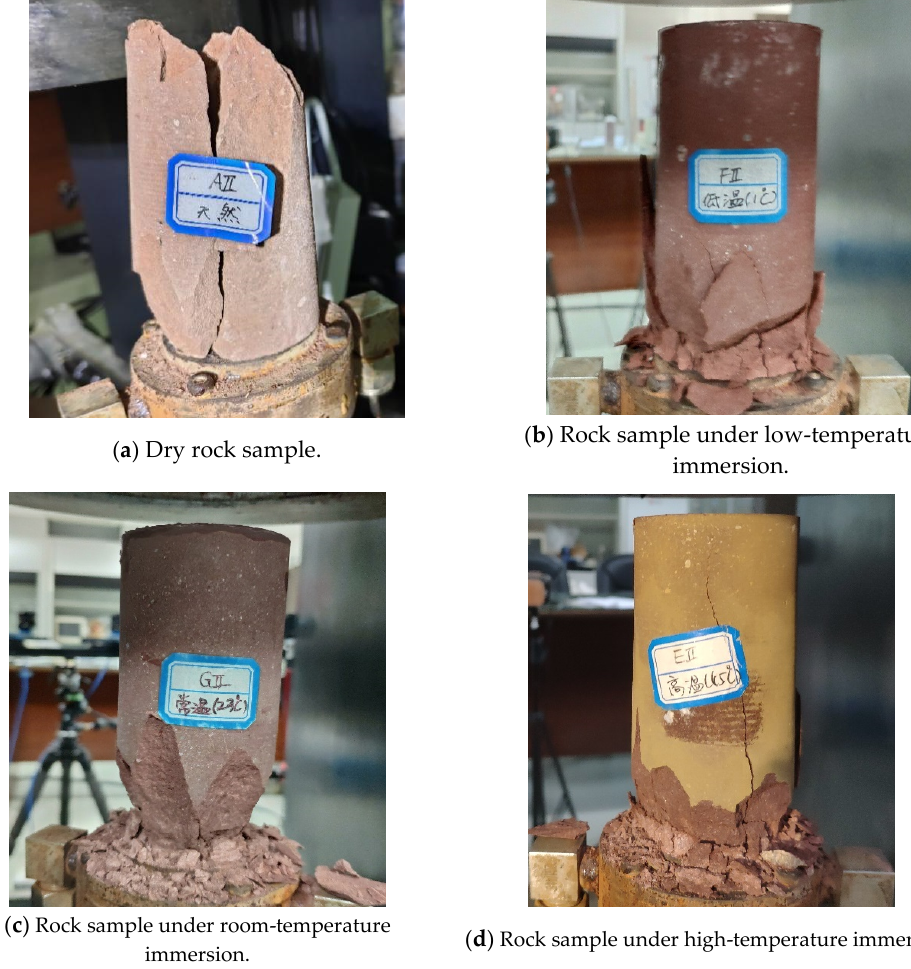
Figure 11. Specimens after failure under uniaxial compression testing. Table 3. Rock sample compressive strength results.